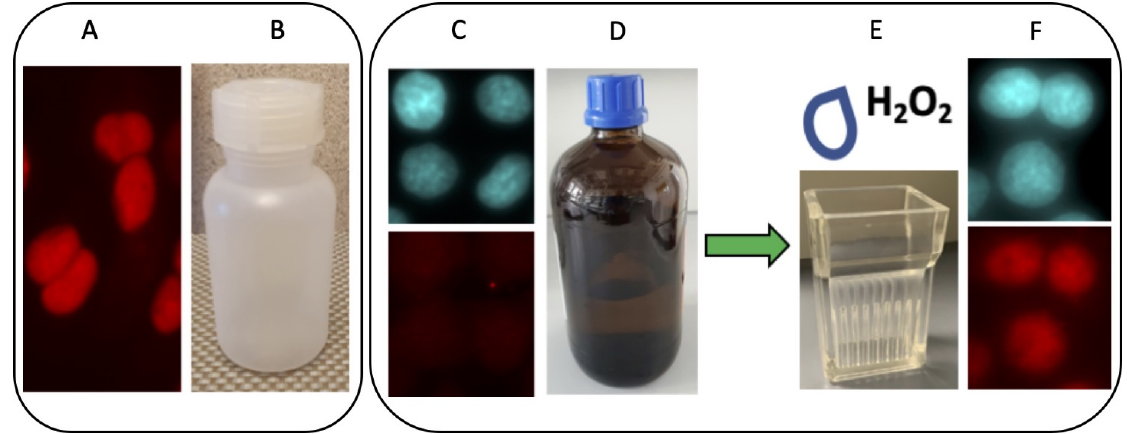
Figure 2. Accessibility of the epitope recognized by the anti-La mAb 7B6. Influence of fixation. ( A ) Cells were stained with the anti-La mAb 7B6. ( B ) The cells in ( A ) were fixed with methanol that was stored in a plastic bottle. ( C ) Cells were stained by the anti-La mAb 7B6 (lower panel). DAPI staining was performed to visualize the presence of cells (upper panel). Cells in ( C ) were fixed with methanol of analytical grade that was stored in a dark brown glass bottle ( D ). A single drop of hydrogen peroxide was added to the PBS in the washing chamber ( E ), and the staining procedure of the cells in ( C ) was repeated ( F ).